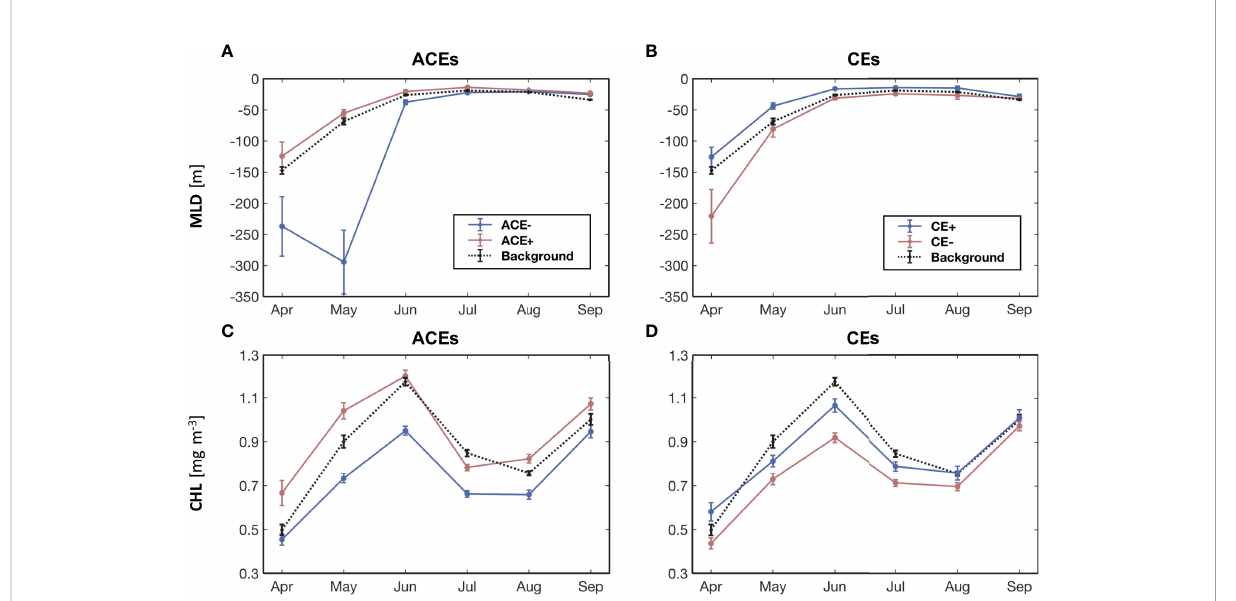
FIGURE 7 Monthly (A) MLD and (C) CHL for ACE- (blue lines) and ACE+ (red lines); monthly (B) MLD and (D) CHL for CE+ (blue lines) and CE- (red lines); background values (dashed black lines) outside eddies. Standard errors within each month are shown as vertical bars. The differences in MLD between (A) ACE+ and ACE-, (B) CE+ and CE- are signi fi cantly at the 95% con fi dence level. The differences in CHL between (C) ACE+ and ACE-, (D) CE+ and CE- are signi fi cantly at the 95% con fi dence